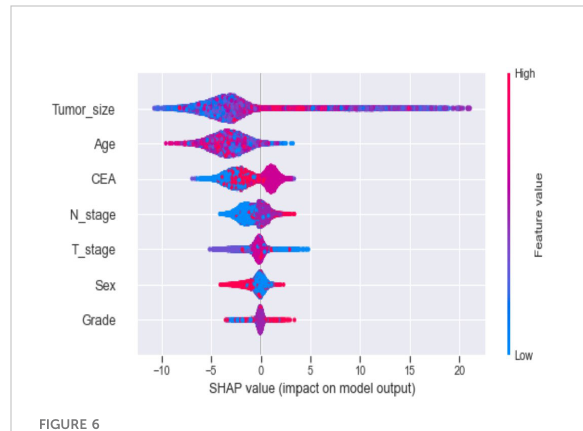
FIGURE 6 The Shapley Additive explanation (SHAP)